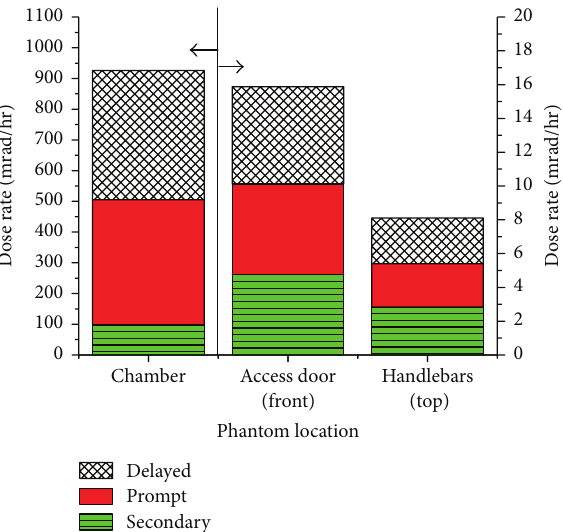
Figure 6: Calculated gamma-ray dose rates to various locations of the irradiator. Note the use of different vertical axes.